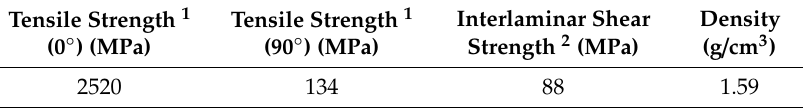
Table 1. The mechanical properties of carbon fiber reinforced plastics